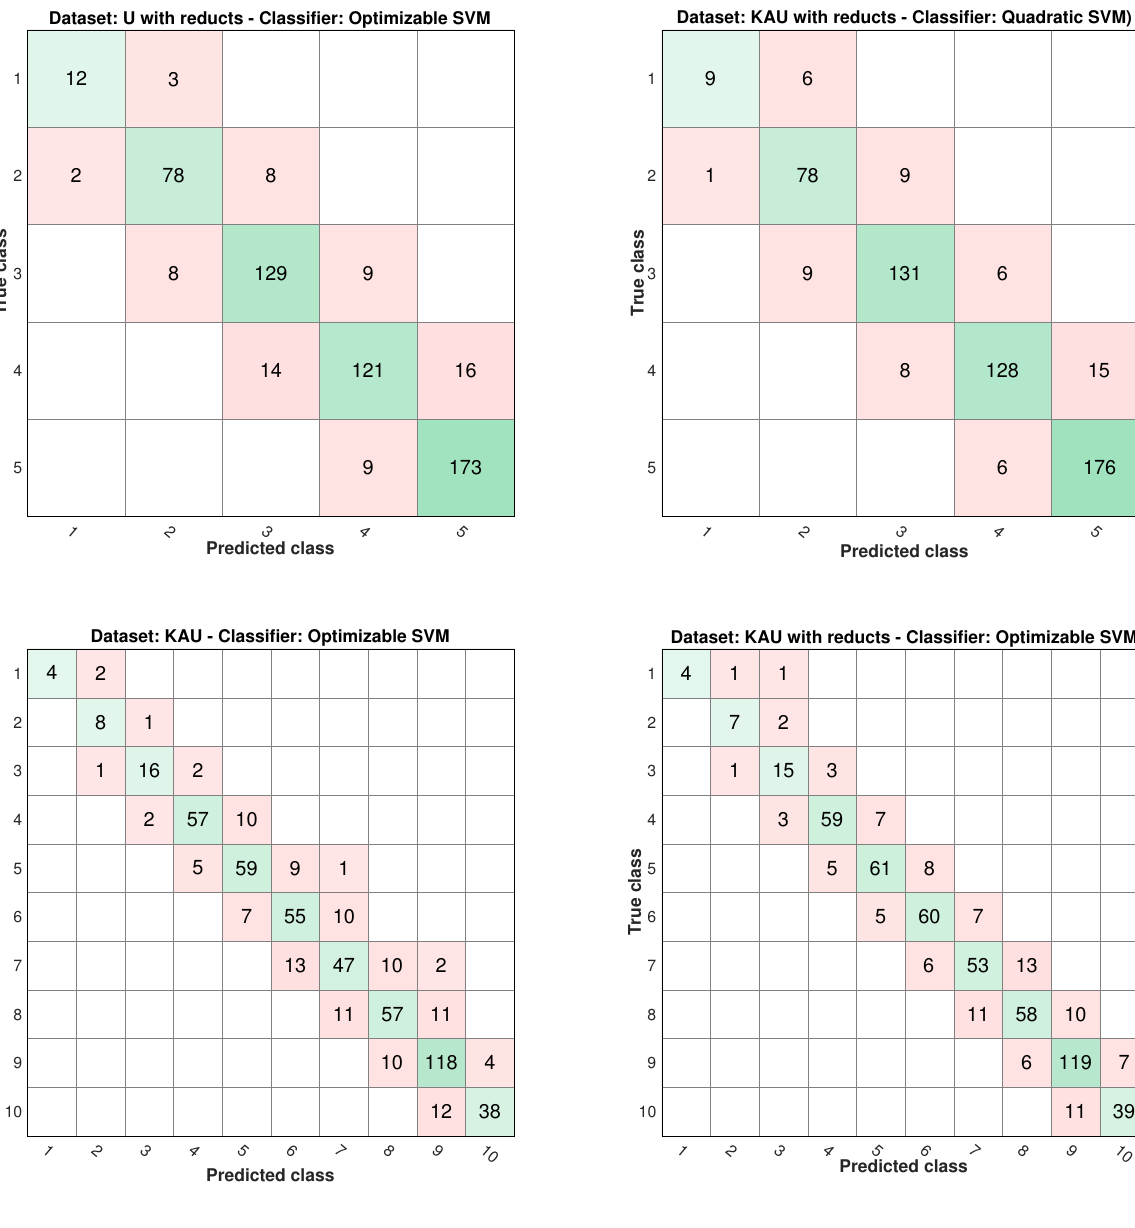
Figure 16. Distributions of KAU predicted